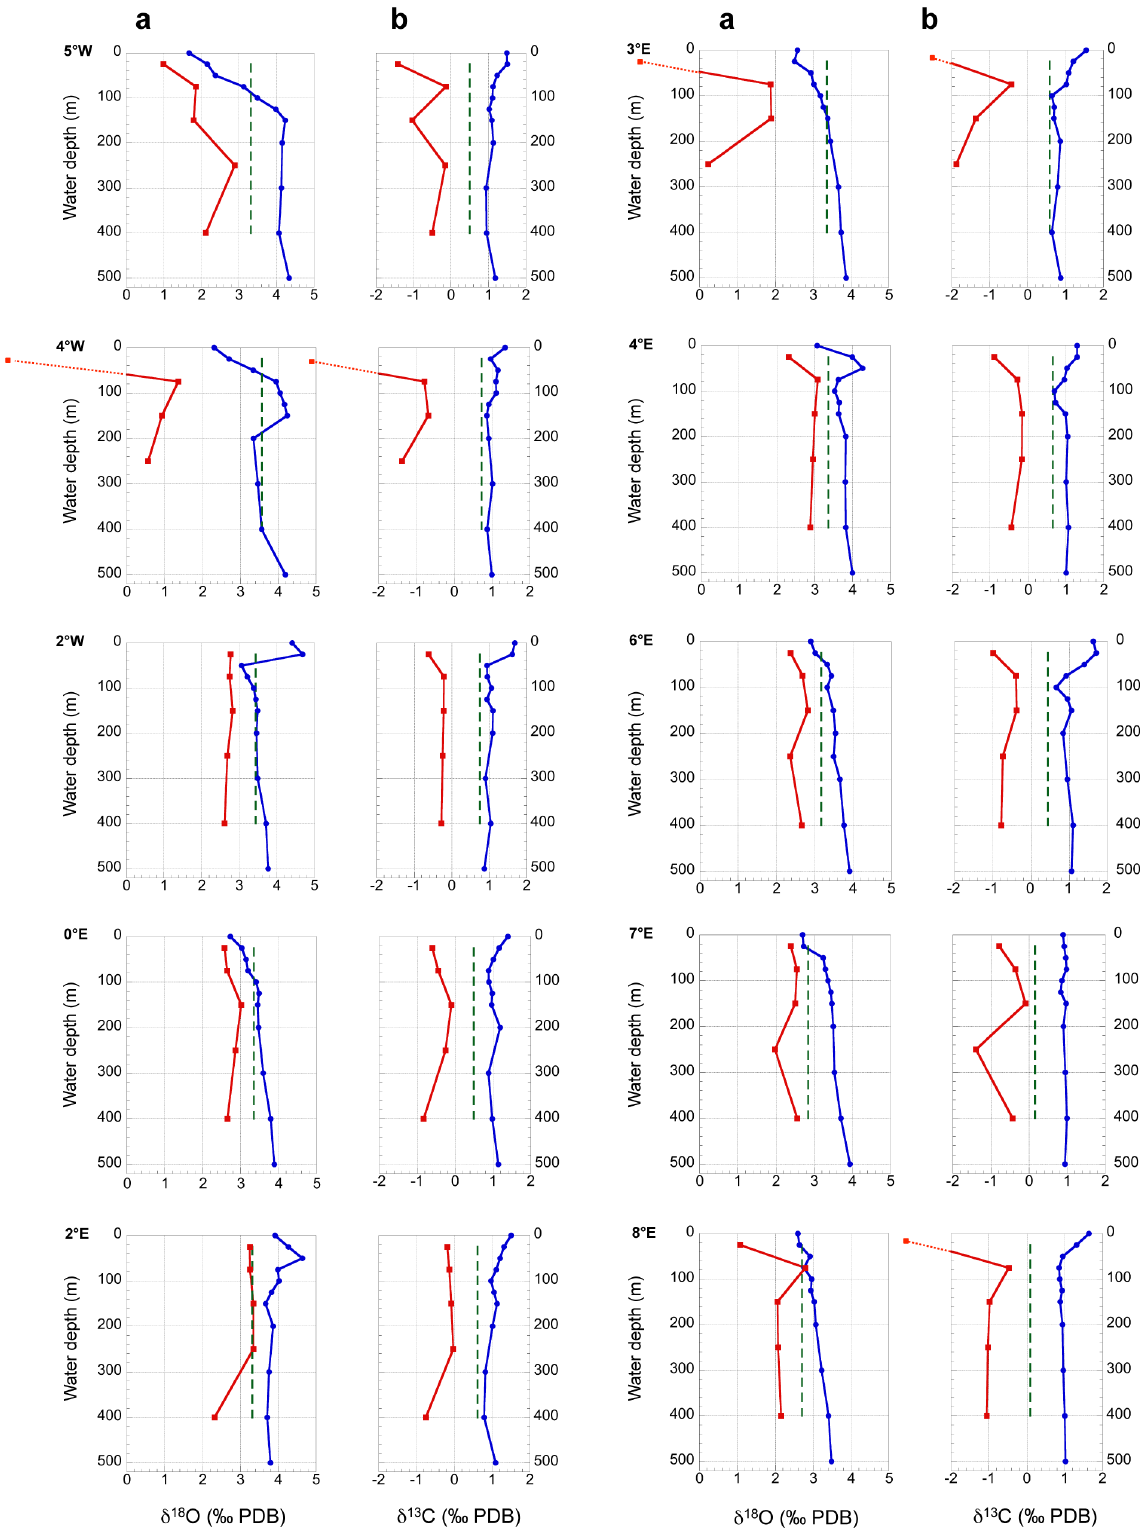
Figure 5. (a) δ 18 O and (b) δ 13 C values of N. pachyderma from the water column (red squares) and from the sediment surface (green dashed line). The blue dots indicate (a) the equilibrium calcite and (b) the δ 13 C DIC profile of the water